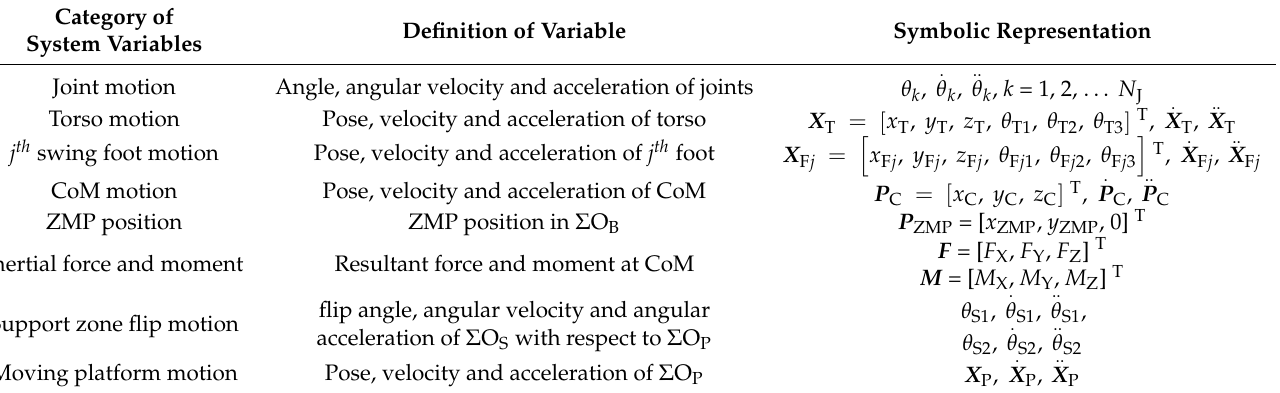
Table 2. System variables of a general model for stability training of legged robots.